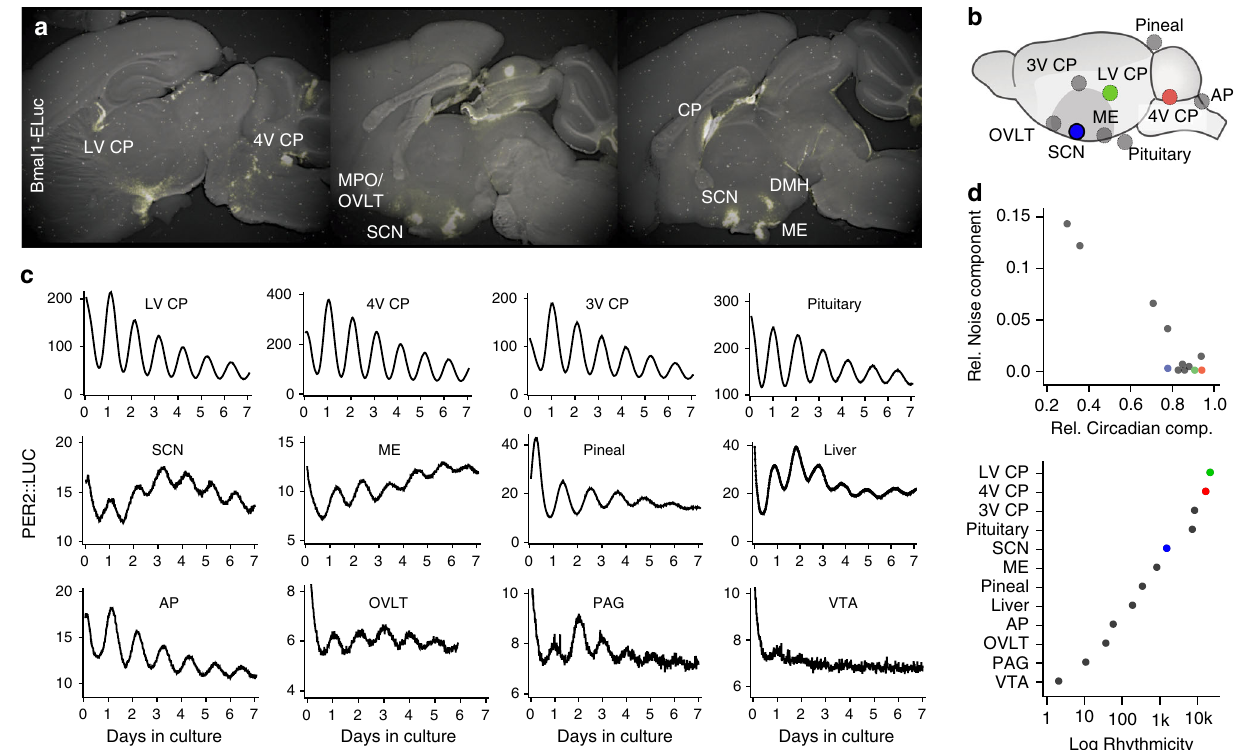
Fig. 1 Multiple brain loci harbor circadian clocks. a Brain loci expressing Bmal1-ELuc. b Sampled brain loci for isolated explant culture. c Representative PER2::LUC oscillations in isolated culture, sorted by the rhythmicity score. d The relative circadian component and the noise component in the PER2::LUC oscillations (upper) and the rhythmicity score calculated by the ratio of the two (lower). Each dot indicates an ensemble average of tissues of the same kind (green: LV CP, red: 4V CP, and blue: SCN). The spectral power of each component is resolved by a discrete wavelet transform. LV CP choroid plexus of lateral ventricle, 4V CP choroid plexus of fourth ventricle, 3V CP choroid plexus of third ventricle, Pituitary pituitary gland, SCN suprachiasmatic